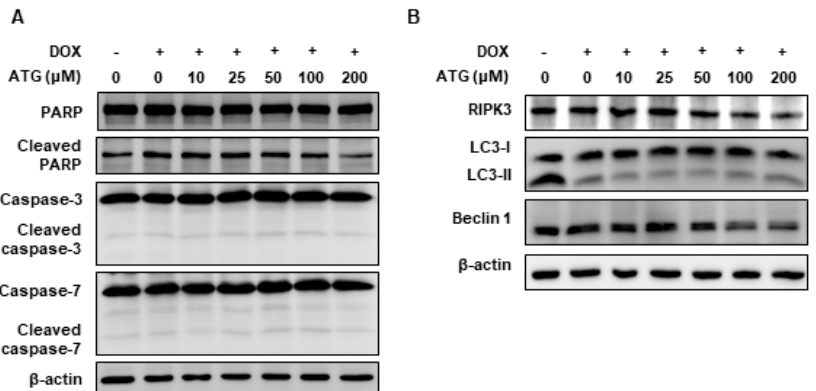
Figure 4. Effects of ATG/DOX co-treatment on the activations of caspase-3 and -7 and on the expressions of necroptosis and autophagy factors in MDA-MB-231 cells. ( A , B ) Cells were attached for 24 h and then co-treated with 0.2 μ M DOX and various concentration of ATG (0–200 μ M) for 72 h in DMEM medium supplemented with 2% FBS. –: 0.2 μ M DOX-untreated, +: 0.2 μ M DOX-treated ( A ) ATG/DOX co-treatment did not affect the cleavages of poly (ADP-ribose) polymerase (PARP), caspase-3, or caspase-7. Proteins in whole cell lysates were separated by 10% or 15% SDS-PAGE and transferred to PVDF membranes. All experiments were conducted independently three times. ( B ) ATG/DOX co-treatment did not affect the expression of receptor interacting serine/threonine kinase 3 (RIPK3), LC3-II or Beclin. Proteins in whole cell lysates were separated by 8% or 15% SDS-PAGE and transferred to PVDF